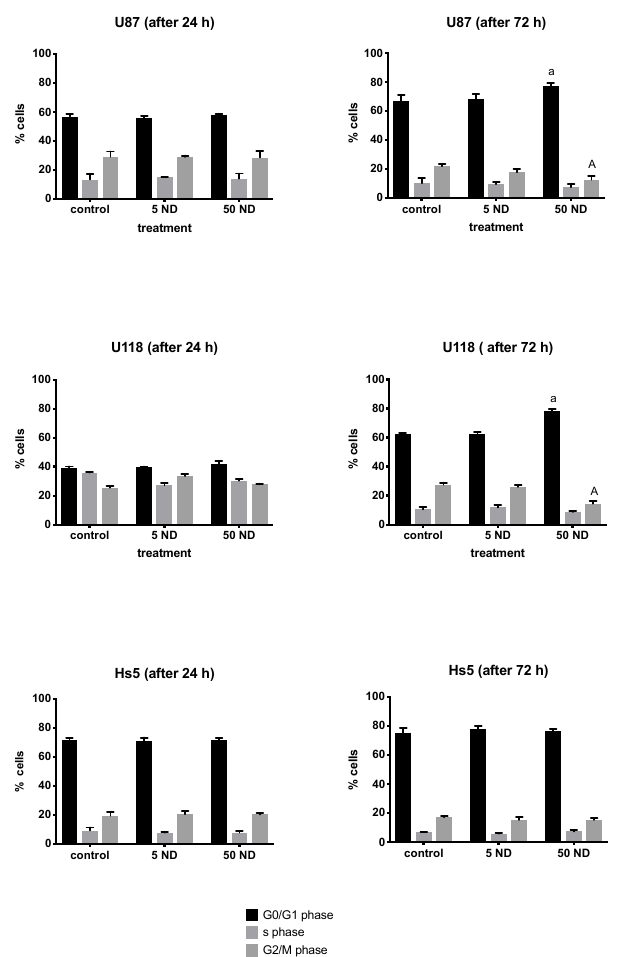
Figure 7. Flow cytometric analysis of Hs5, U87, and U118 cell cycle ND treatment at concentrations of 5 and 50 μ g/mL for 24 and 72 h. Values represent the relative percentage of cells at the G0/G1, S, and G2/M phases of the cell cycle. Groups marked with different letters (a, A) are significantly different ( p < 0.05). G 0 , resting phase (outside of replication); G 1, interval between mitosis and initiation of DNA replication; S, phase of DNA replication; G 2 , interval between DNA replication and mitosis; M, Mitosis.